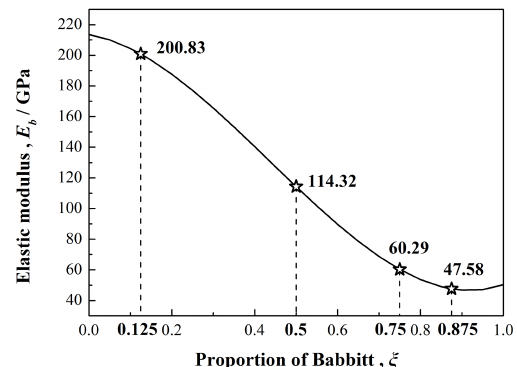
Figure 2. Variation curve of elastic modulus with proportion of